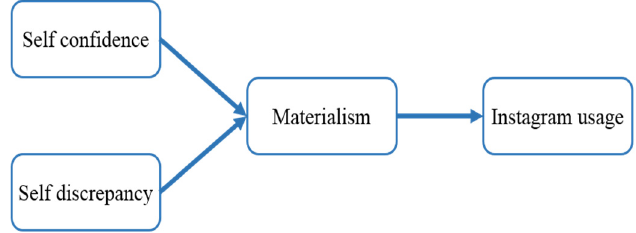
Figure 1. Study 1: Conceptual model.